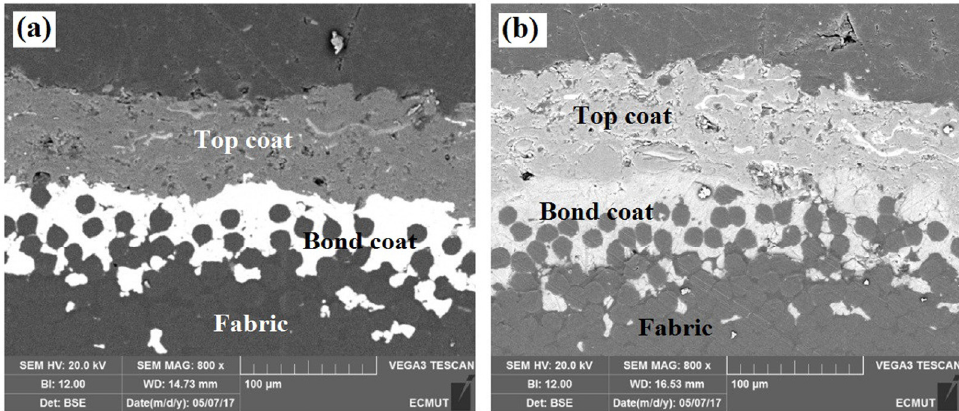
Figure 10. SEM image of the cross-section of aramid fabric coated with ( a ) Cu/ Al 2 O 3 –13%TiO 2 and ( b ) Al/ Al 2 O 3 –13%TiO 2 . Reprinted from [73], Copyright (2020), with permission from Elsevier.